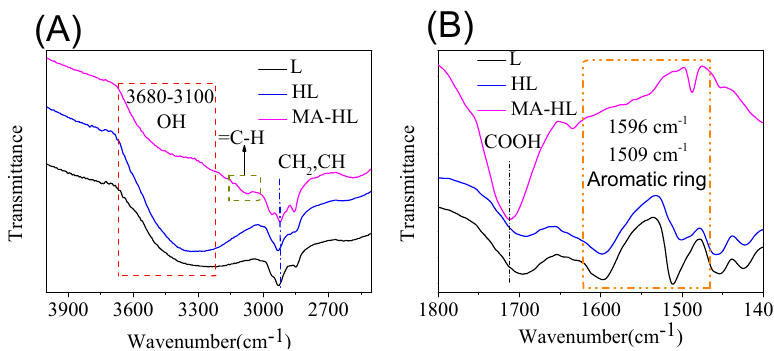
Figure 2. FTIR spectra in the region of 2400–4000 cm − 1 ( A ) and 1400–1800 cm − 1 ( B ) lignin and its derivatives, respectively (L = lignin, HL = hydroxymethylated lignin, MA-HL = maleated lignin).